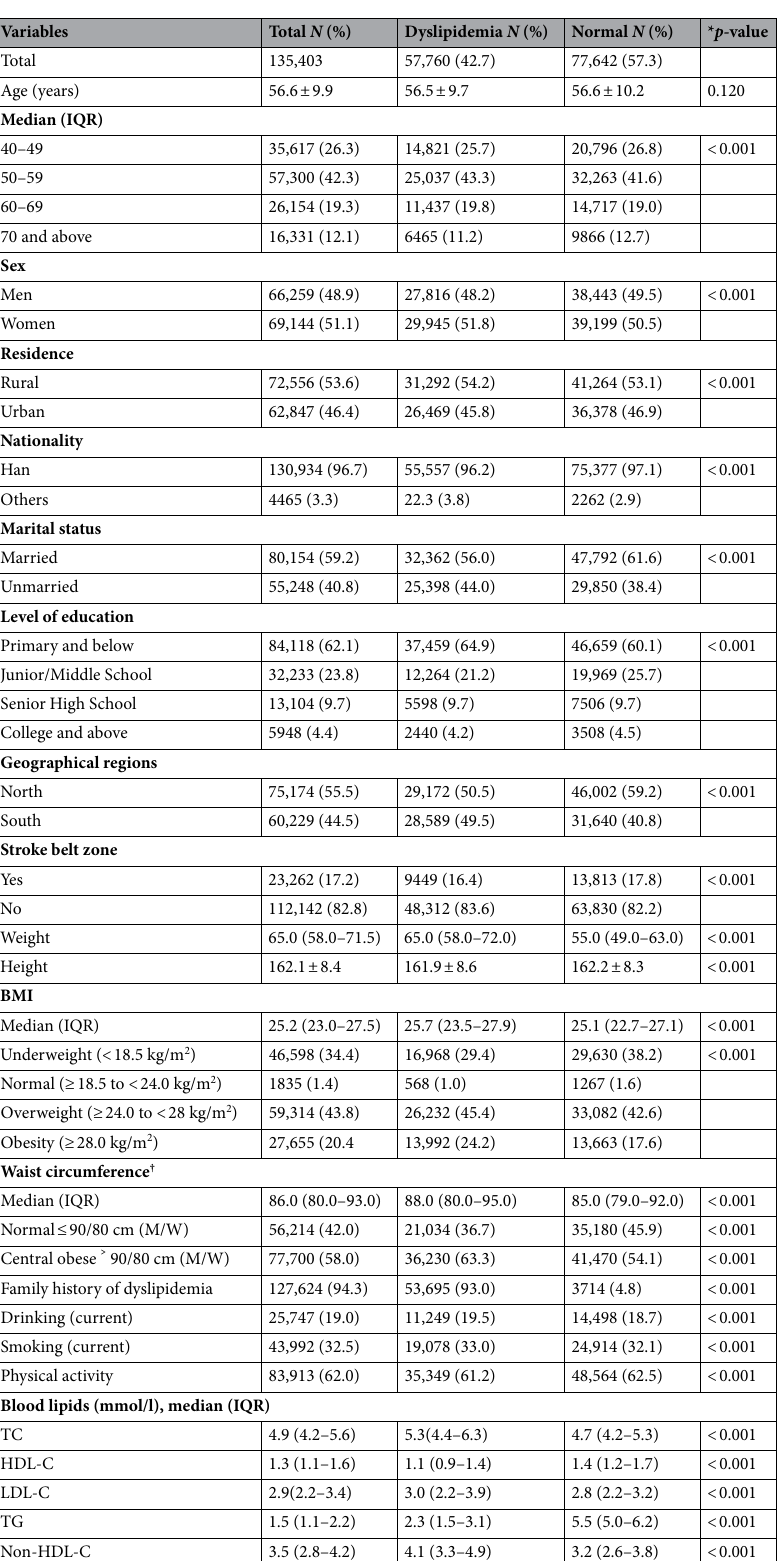
Table 1. Participants’ characteristics and dyslipidemia status. Dyslipidemia was defined as total cholesterol (TC) > 6.22 mmol/L or low-density lipoprotein (LDL-C) > 4.14 mmol/L or high-density lipoprotein